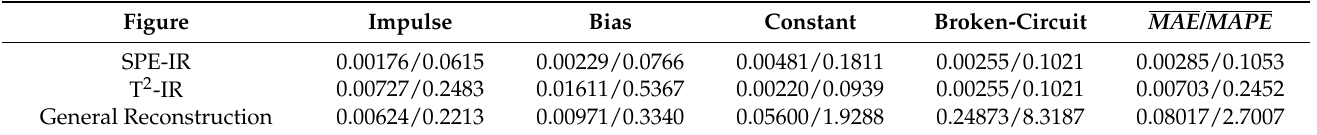
Table 8. Data Recovery Error (MAE/MAPE) of Different Reconstruction Methods.